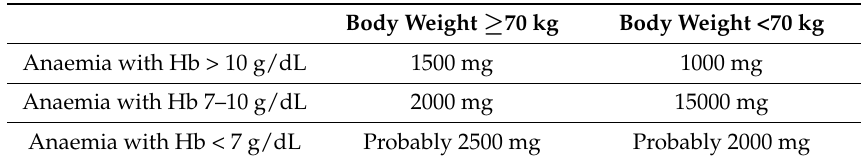
Table 1. Simple estimation of total iron need in patients with anaemia (Hb (g/dL) <13 in men, <12 in